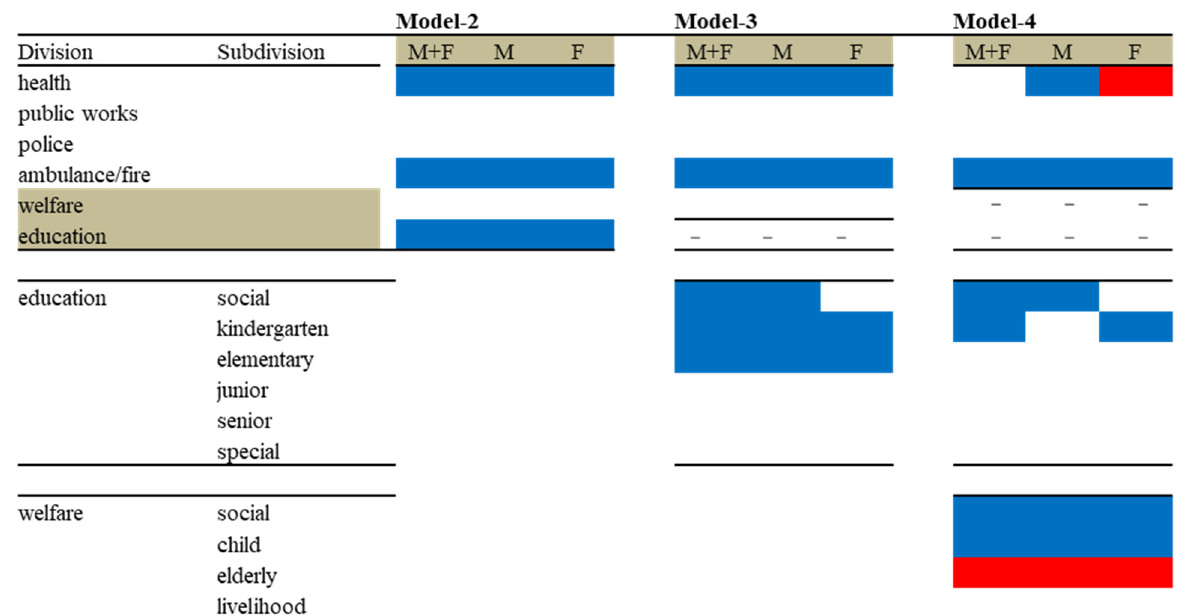
Figure 5. Summary of effects of regional financial expenditure of divisions and subdivisions of education and welfare in prefectures and municipalities on the suicide mortality of males and females together (M + F), males (M), and females (F) from 2009 to 2018. Blue and red columns, significant factors for decreasing and increasing suicide mortality, respectively.